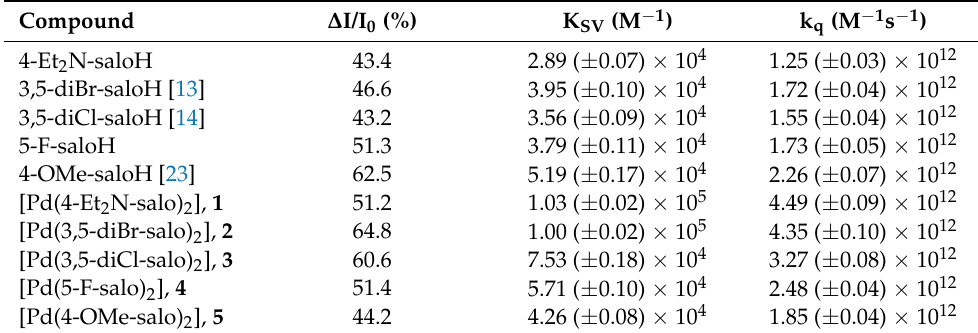
Table 4. Percentage of EB-DNA fluorescence quenching ( ∆ I/I 0 , %), Stern–Volmer constant (K SV in M − 1 ) and EB-DNA quenching constant (k q , M − 1 s − 1 ) for X-saloH and complexes 1 – 5